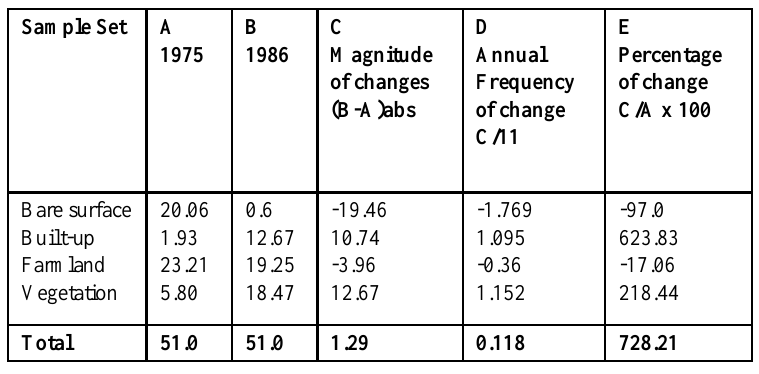
Table 4-Landcover in Heipang-Yelwa (1975,1986 and 2012).